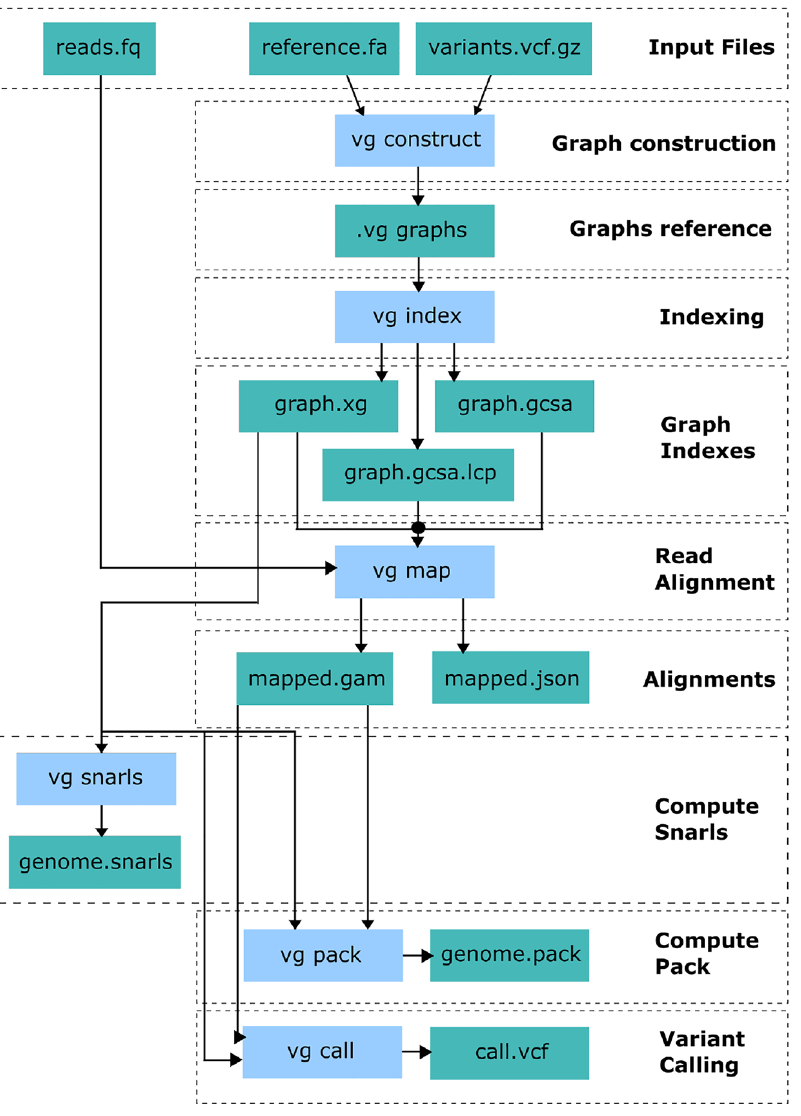
Figure 3: The vg pipeline: graph construction, graph indexing, reads mapping, variant